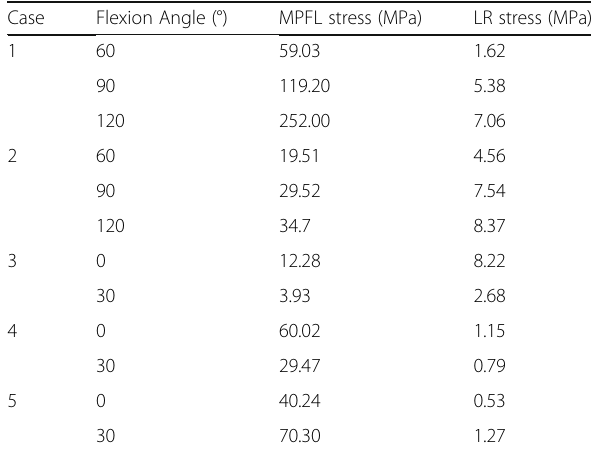
Table 7 MPFL and LR ligaments stress obtained for each reconstruction and position